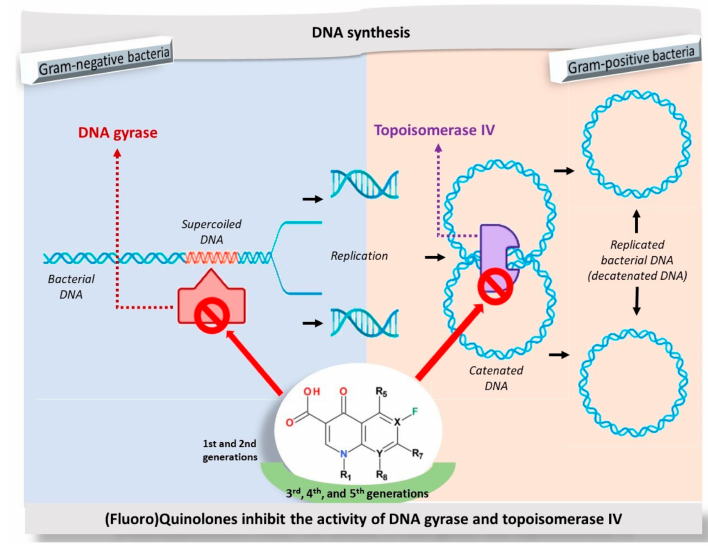
Figure 2. The mechanism of action of antibacterial (fluoro)quinolones.